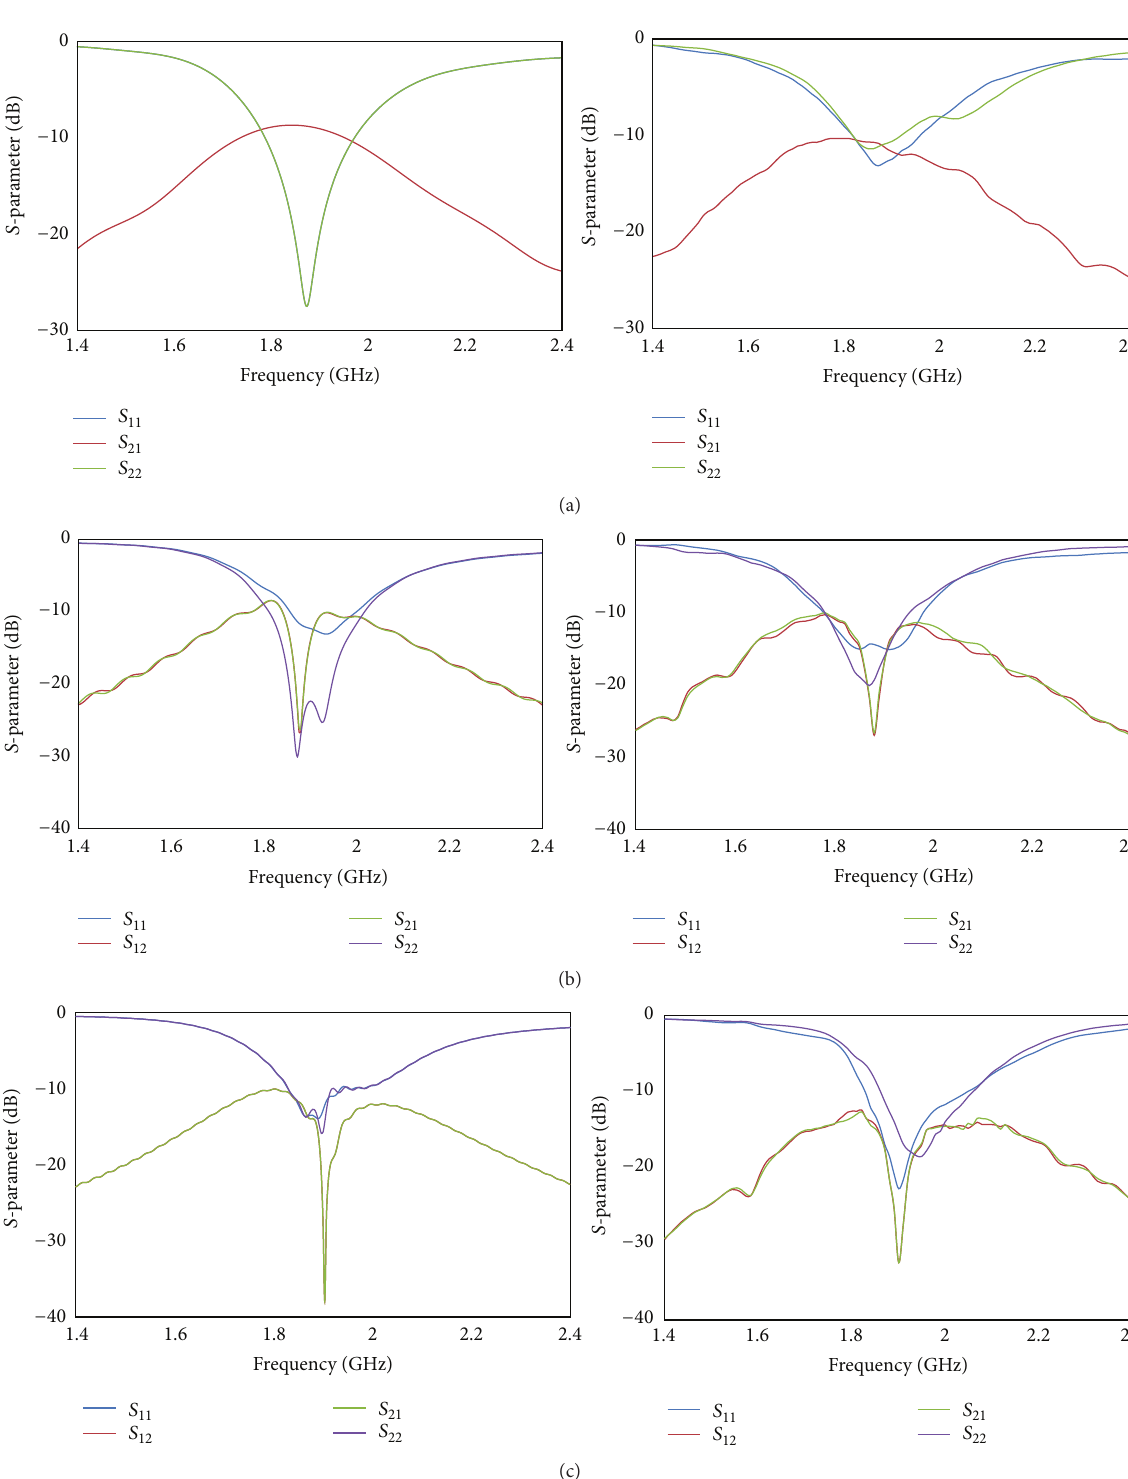
Figure 7: Simulated and measured S -parameters of the PIFA array (a) without and (b) with two and (c) with four double-layered